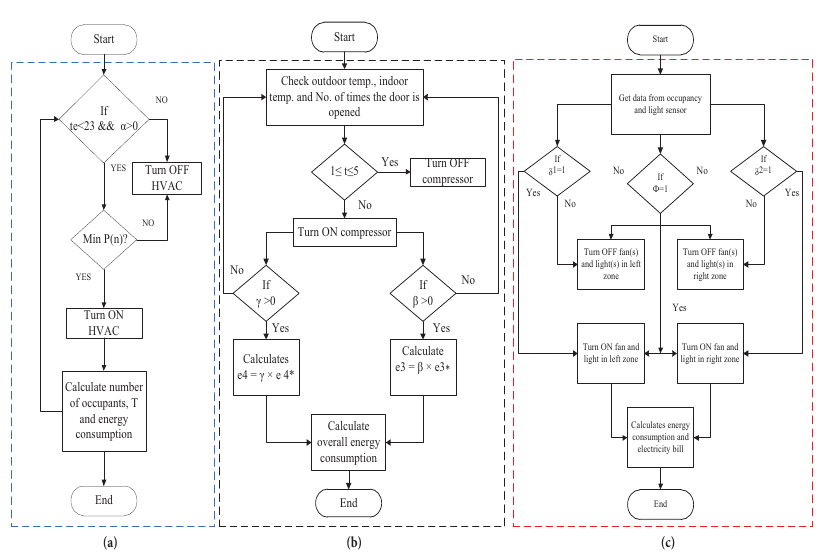
Figure 15. Energy management algorithms of ( a ) HVAC; ( b ) refrigerator and ( c ) ua